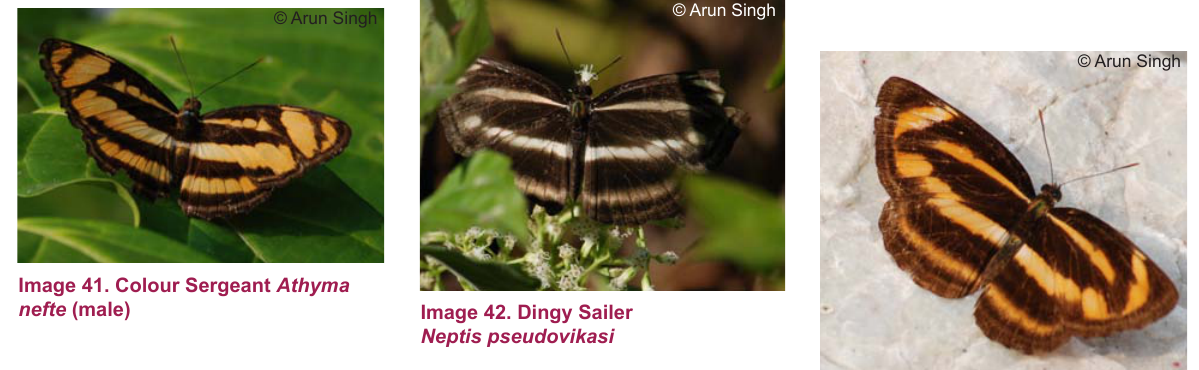
Athyma ranga (male)